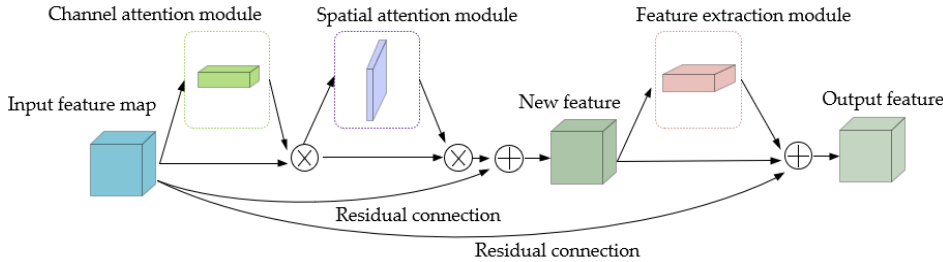
Figure 2. Convolution module structure.